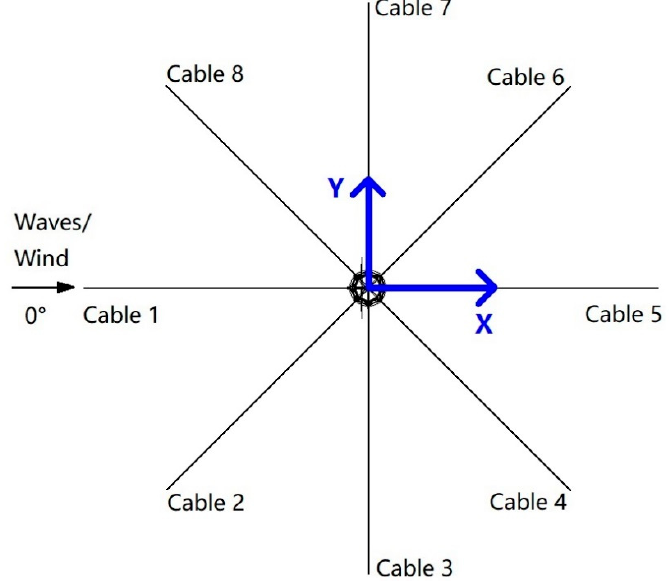
Figure 3. Mooring line layout (top view).